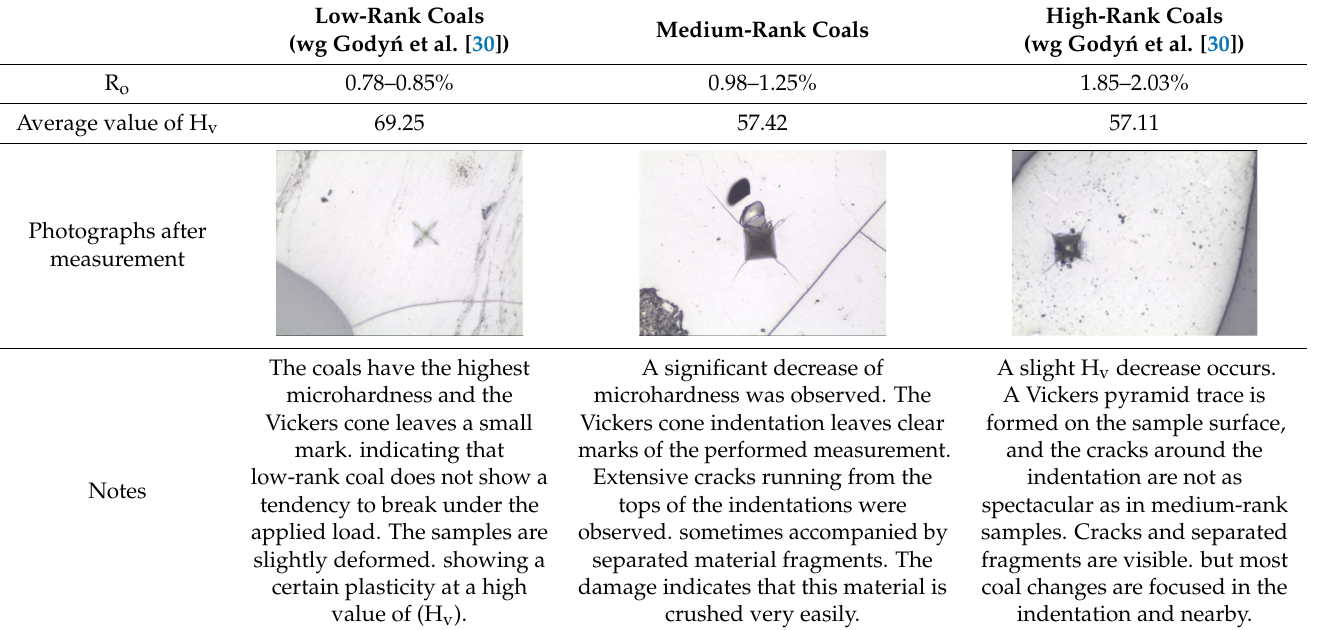
Table 4. Differences in microhardness of coals with different degrees of